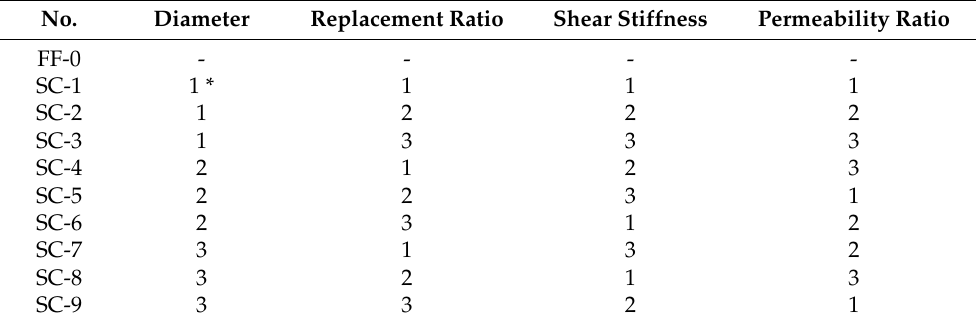
Table 2. Scheme of simulation models.